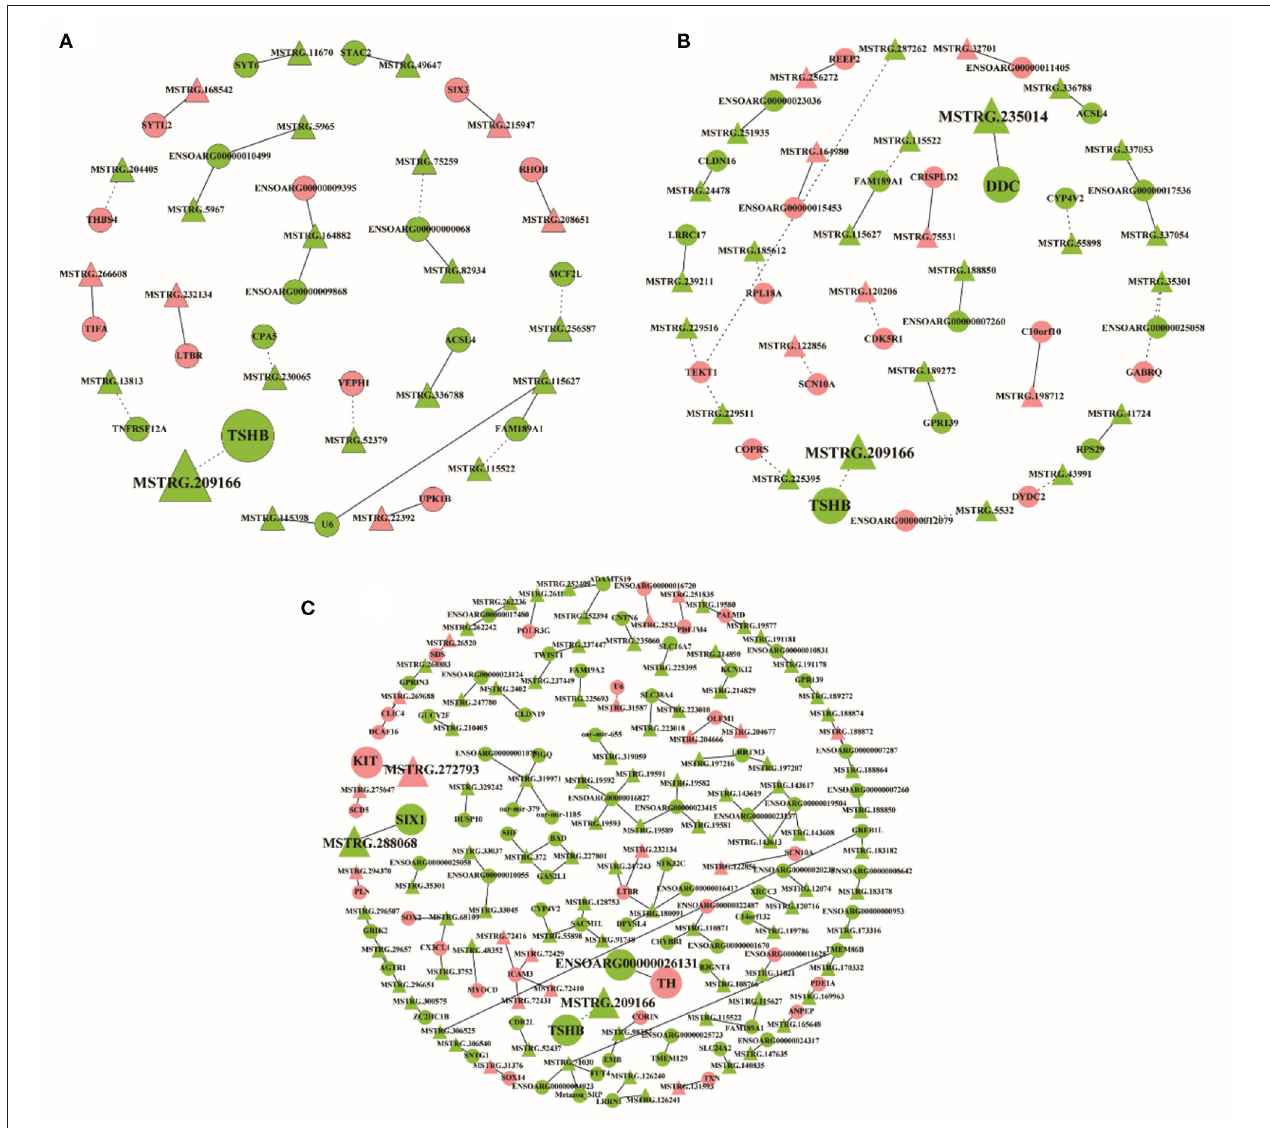
FIGURE 8 | The interaction networks of lncRNAs and their corresponding target gene. (A) The networks for SP21 vs. LP7; (B) the networks for SP21 vs. LP21; (C) the networks for SP21 vs. LP42. The dashed and solid lines represent trans- and cis-regulation functions, respectively. Red and green represent up- and downregulation, respectively. Circles and triangles represent mRNAs and lncRNAs,